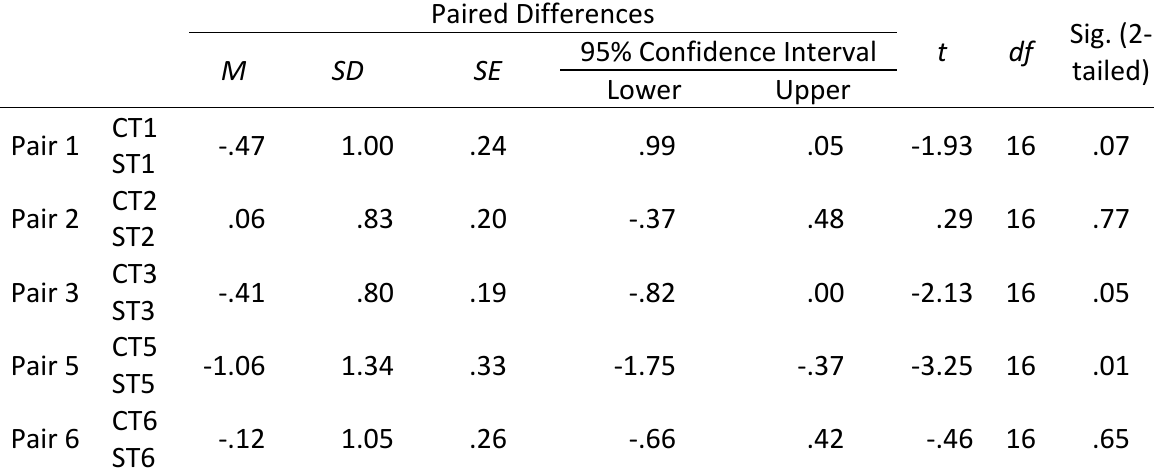
Paired Samples t-Test for Cooperating Teachers’ & Student Teachers’ Frequency of Best Practice Mentoring